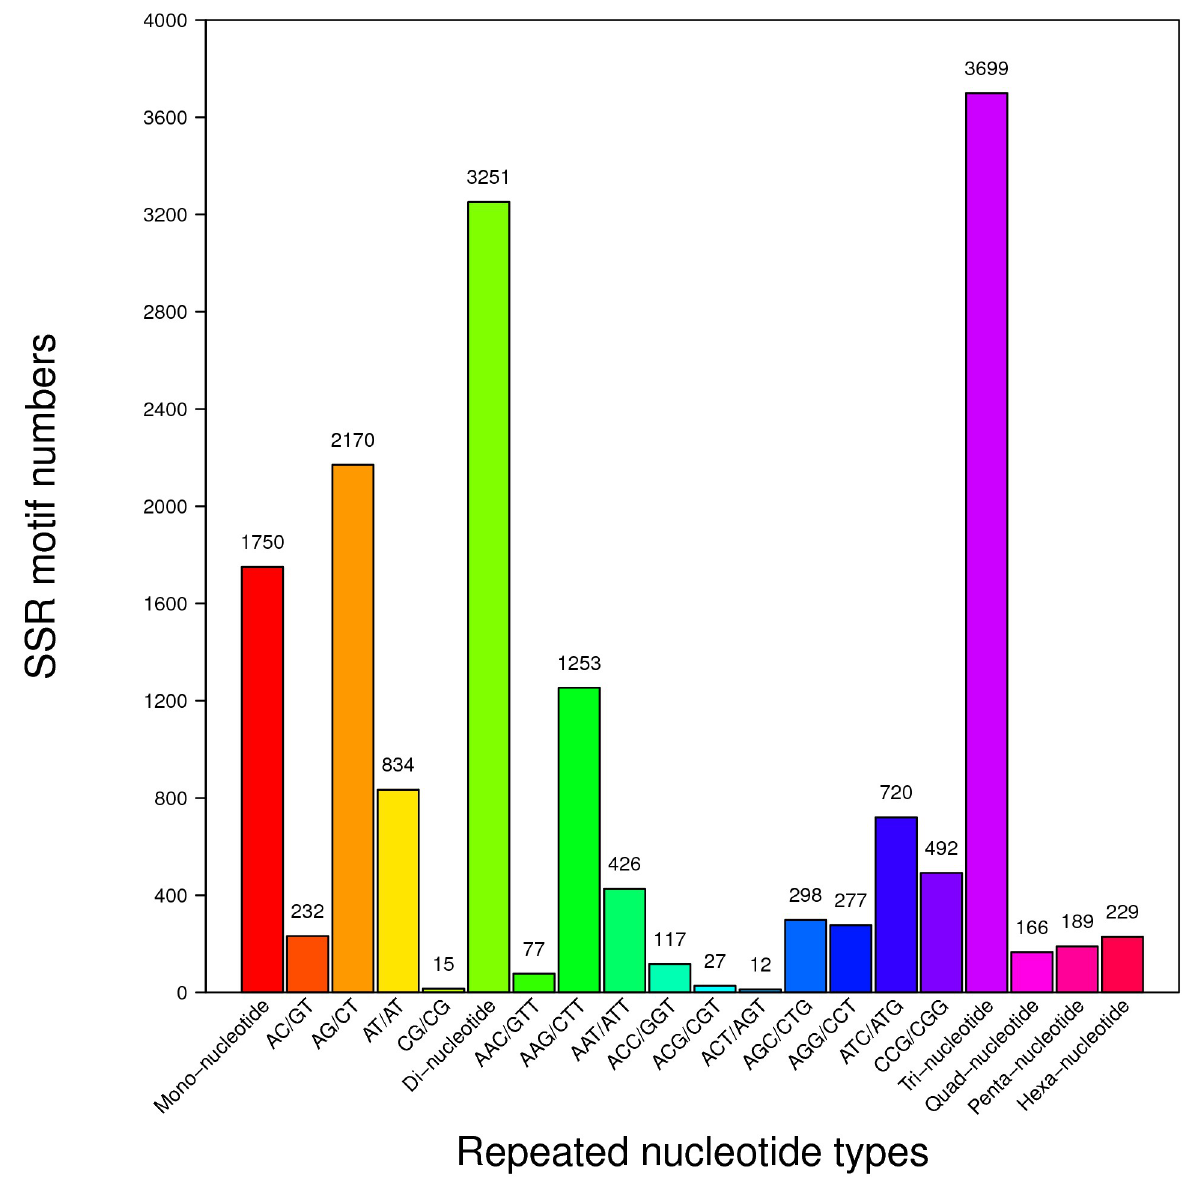
Fig 3. The SSRs repeated nucleotide types for A . emeiensis